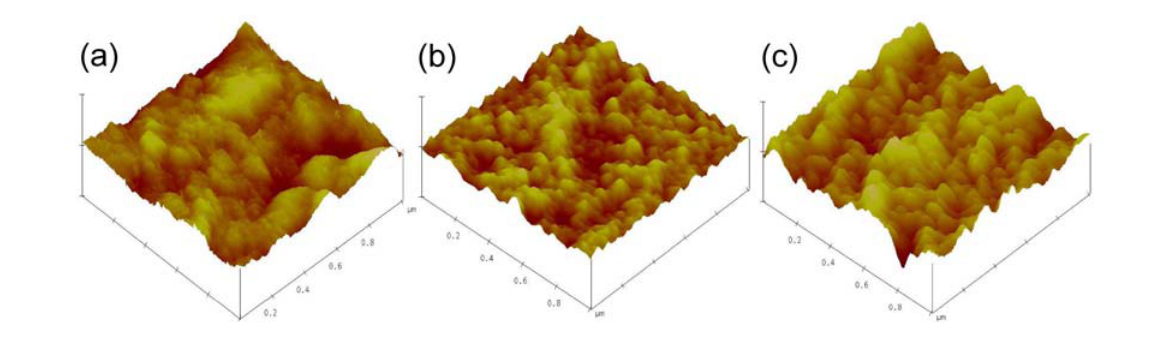
Figure 6. Tapping mode AFM images of: a) pristine cellulose, b) PPy coated cellulose and c) ionic liquid-PPy-cellulose hybrid nanocomposite.